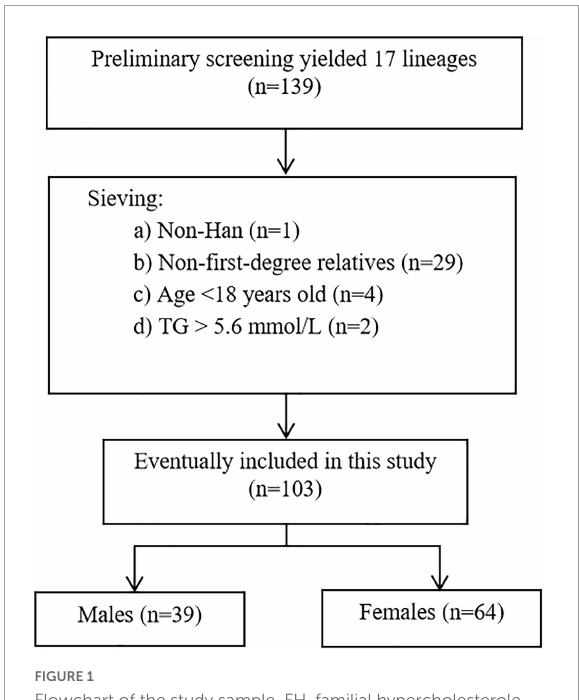
FIGURE1 Flowchart of the study sample. FH, familial hypercholesterole mia; TG,